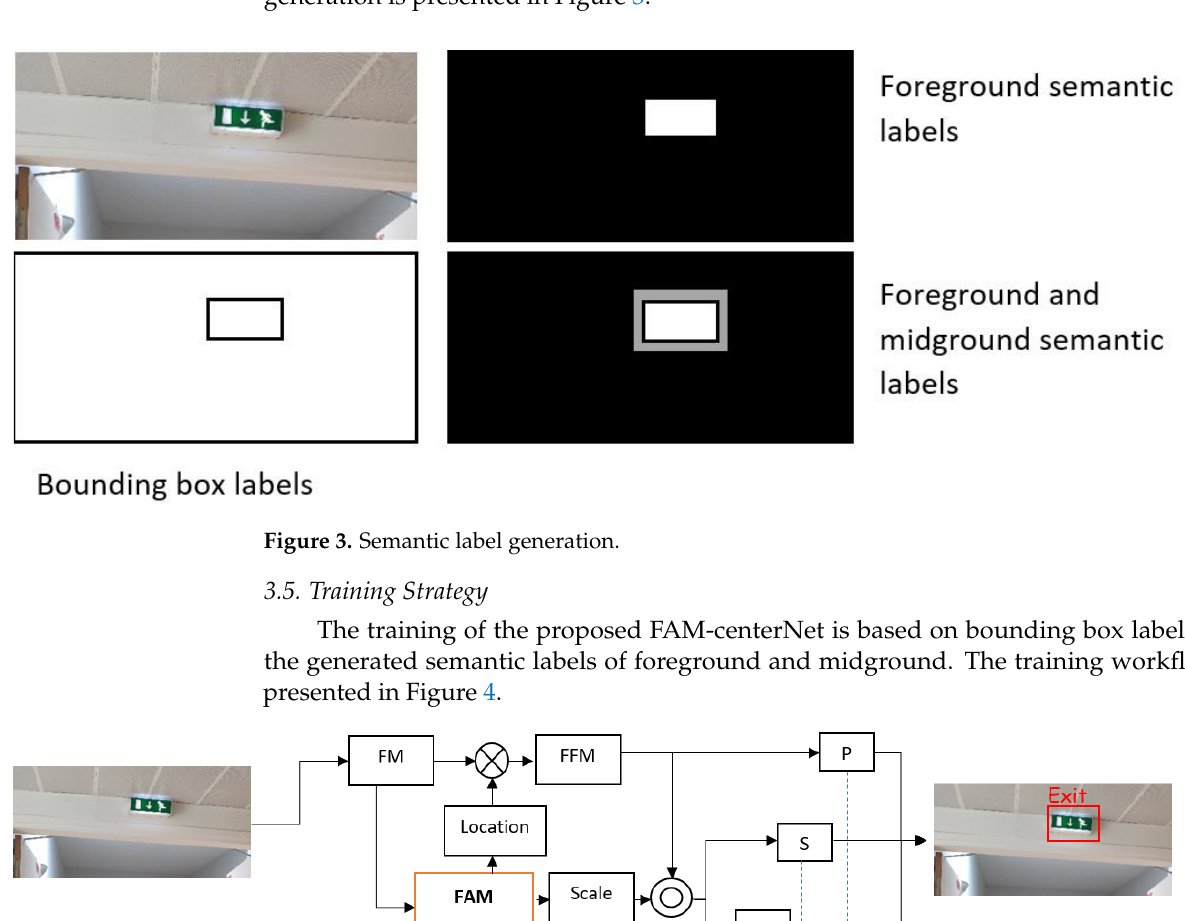
Figure 2. Presentation of background, foreground, and midground in the image.